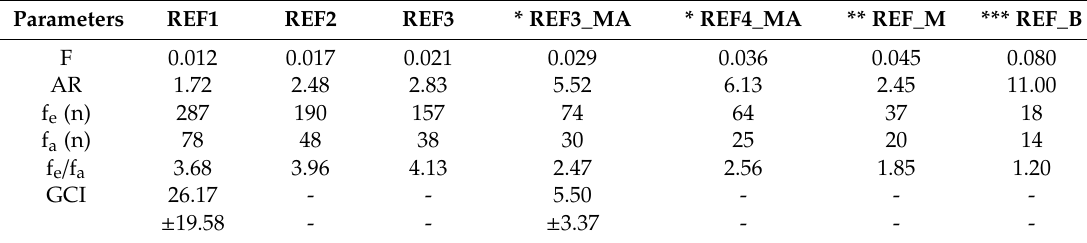
Table 3. Genetic variability parameters of SAA, Maremmano, Murgese, Bardigiano. Parameters REF1